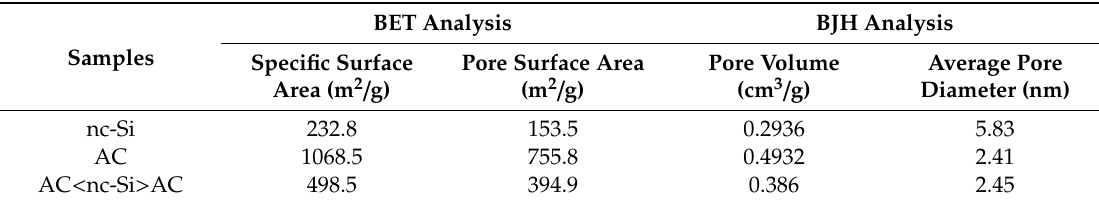
Figure 5. ( a ) Nitrogen adsorption–desorption isotherm (N 2 ADI) characteristics and ( b ) pore characteristics of nc-Si, AC, and AC<nc-Si>AC nanocomposites. Table 1. Specific surface area and pore characteristics of the BRH-derived (a) nc-Si, (b) AC, (c) AC<nc-Si>AC nanocomposites.